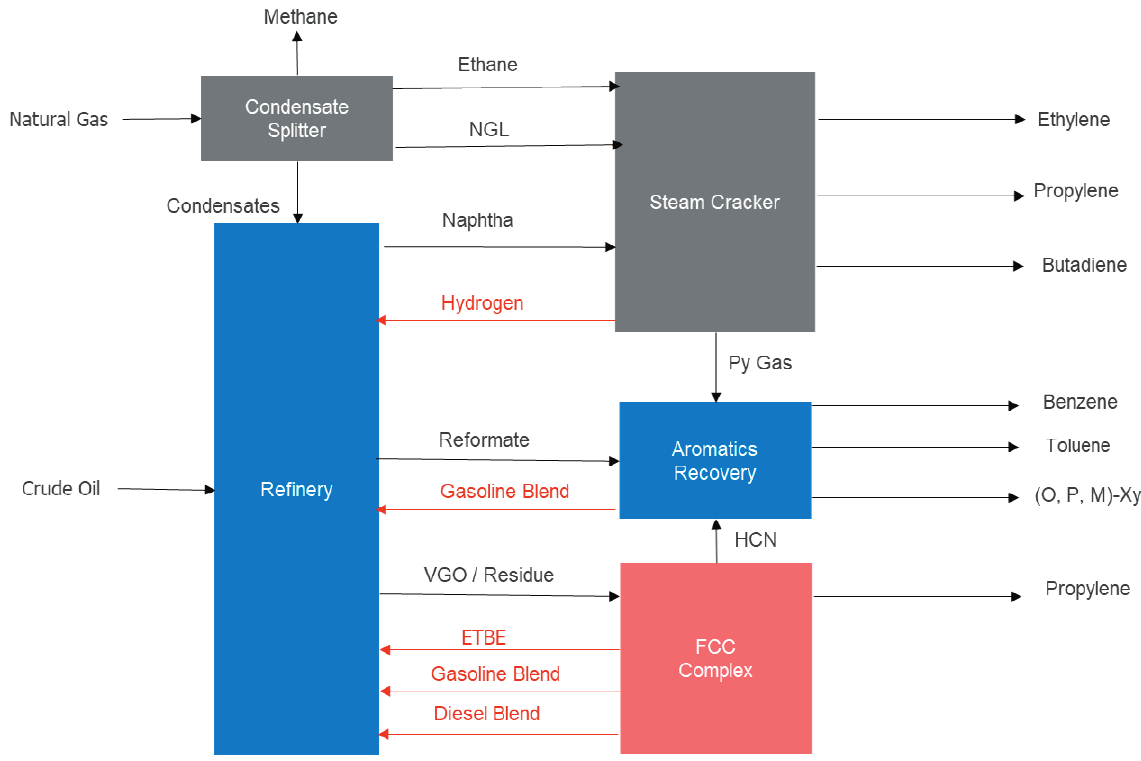
Figure 8. Refinery-Petrochemical